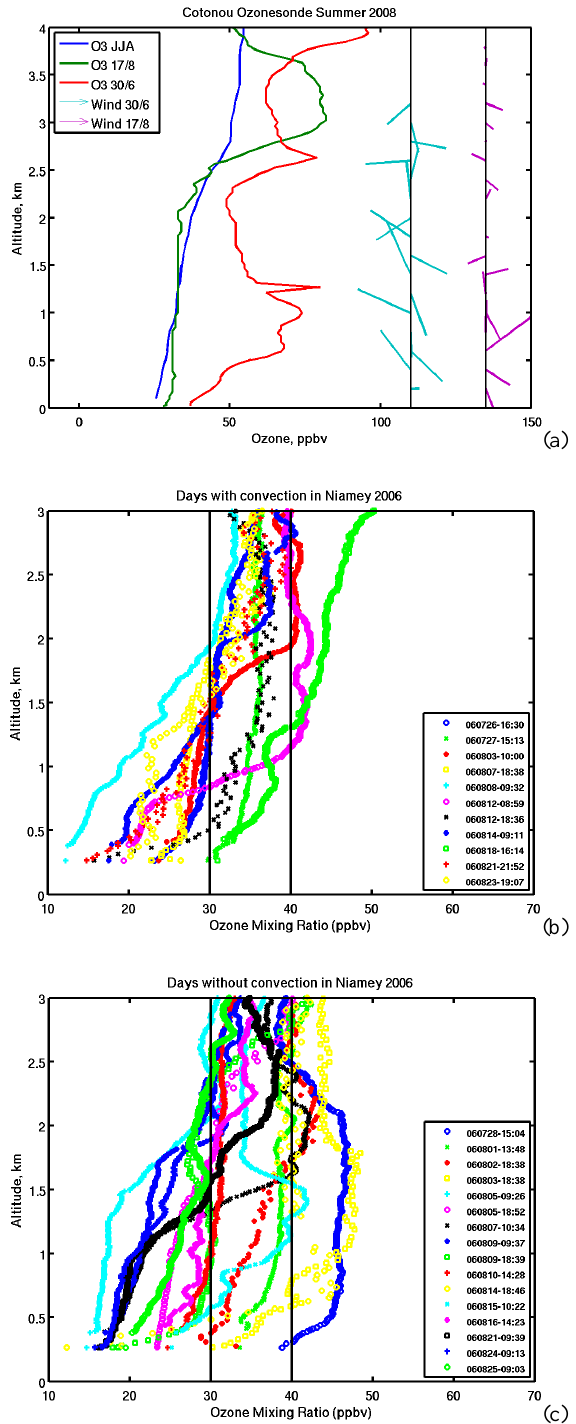
Fig. 13. (a) Three ozone sonde vertical profiles in Cotonou from Thouret et al. (2009): June/July/August mean, 17 August and Fig. 13. (Top panel, (a) ) Three ozone sonde vertical profiles in Cotonou from Thouret et al. (2009): 30 June 2006. Wind vector vertical profiles are shown for 17 and June/July/August mean, August 17 and June 30 2006. Wind vector vertical profiles are shown for August 30 August (the base of the wind vector is on the solid line). (b) , (c) Ozone sonde vertical profiles in Niamey measured between 17 and 30 (the base of the wind vector is on the solid line). (Bottom panel, (b,c) ) Ozone sonde vertical 26 July and 25 August 2006 for days with (b) and without (c) nearby profiles in Niamey measured between July 26 and August 25 2006 for days with (left) and without (right) deep nearby deep convection.